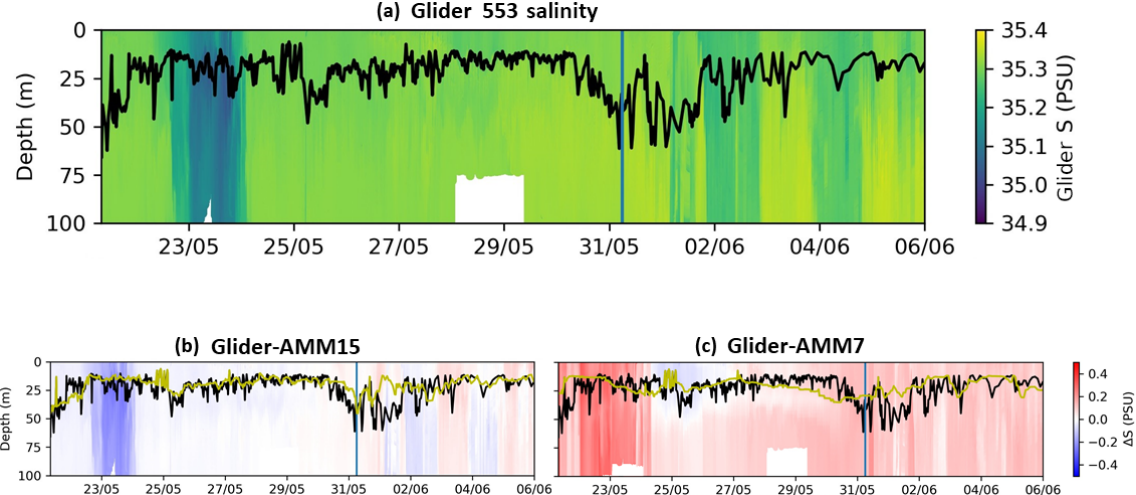
Figure 16. Top 100m of salinity profile along glider 553-100 trajectory. (a) Salinity measured by the glider. (b) Difference between the glider and AMM15. (c) Difference between the glider and AMM7. The vertical blue line represents time when the glider goes over the shelf break, crossing the 200m isobath. Before that time, the glider is on the shelf. The black line is the MLD computed from the glider measurements; the yellow line is the model